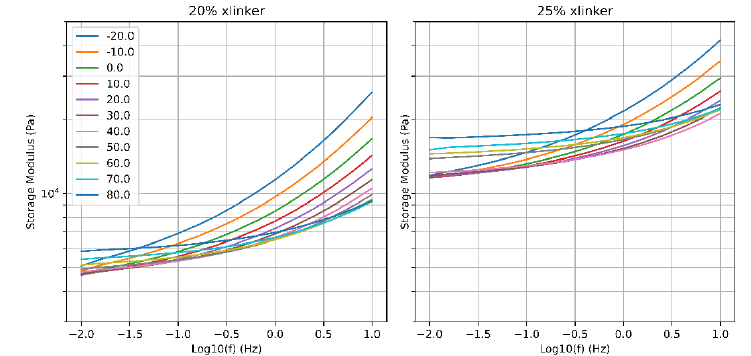
Fig. 3. Storage moduli for isothermal frequency sweeps for Sylgard184 with 20% (left) and 25% (right) of the recommended